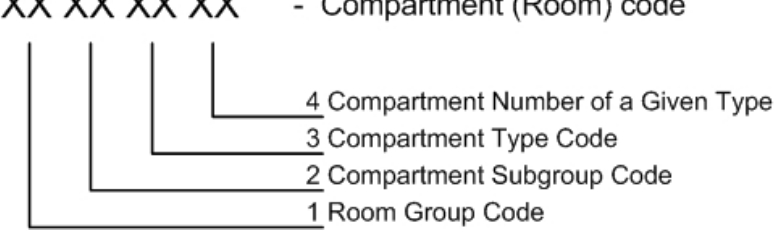
Figure 11. Ship structure classification.